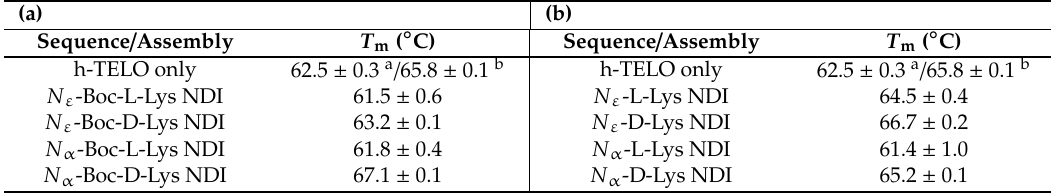
Table 6. The T m values of dsDNA only compared to the T m of ( a ) dsDNA-Boc-protected-NDIs and ( b ) dsDNA-deprotected-NDIs as determined from VT CD studies.